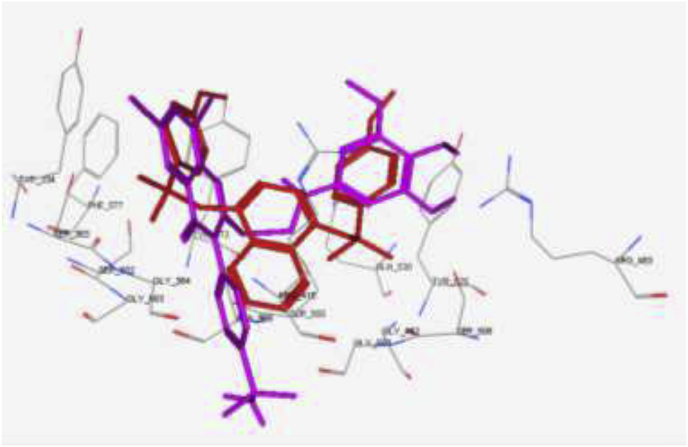
Superimposition of compound 15 (magenta) and the co-crystallized ligand (red) showed that they adopt the same orientation inside the receptor. (For interpretation of the references to color in this figure legend, the reader is referred to the Web version of this article.)